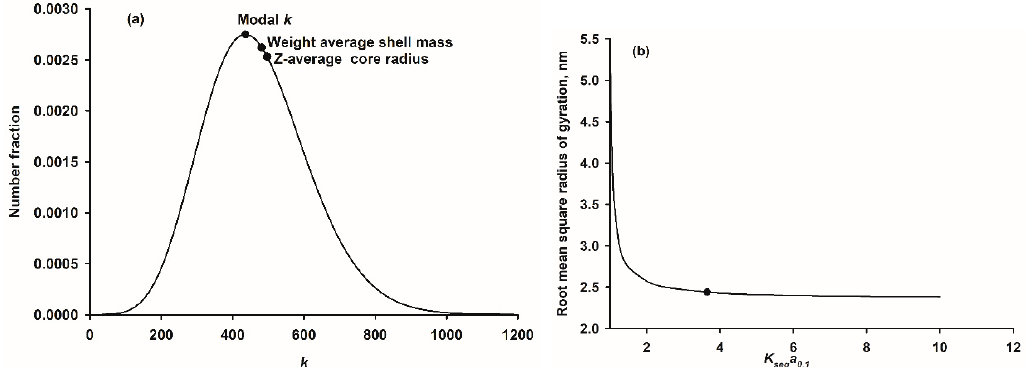
Figure 8. Comparison of calculated with experimental properties of the nanocluster complexes prepared with β -casein 1–25. ( a ) Theoretical size distribution matching that of CaP nanoclusters prepared with β -casein 1–25. The abscissa is the number of molecules of CaP in the core, k . The distribution is also shown as curve 2 in Figure 5 but with core radius as the abscissa. The example normalized distribution is consistent with the experimental average mass and radius of the core (Table 2). Marked on the distribution are the coordinates corresponding to the peak maximum and the core weight average molar mass and root mean square Z-average radius. ( b ) Dependence of the calculated root mean square radius of gyration of the core, determined by small-angle scattering, on the value of K seq a 0,1 in the range 1–10. The experimental value determined by small-angle neutron scattering at the protein matching contrast is shown as a data point [111]. The conclusion is that provided there is excess of the strongly binding phosphopeptide, the core radius is essentially constant.